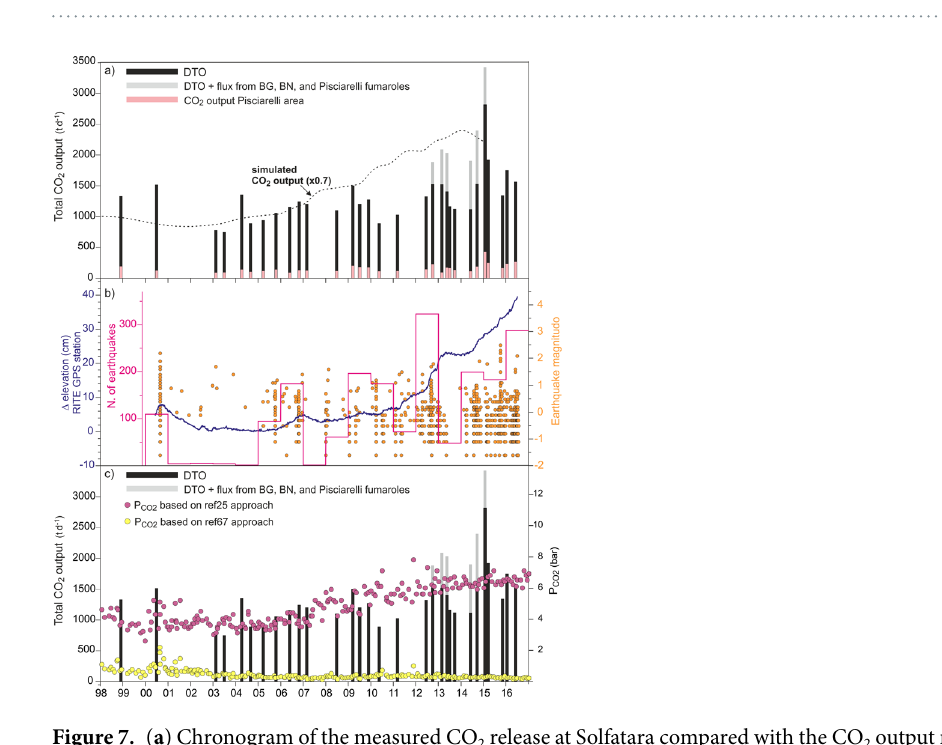
Figure 6. Time variation of the Solfatara background flux (SBF) ( a ) and diffuse degassing structure (DDS) extension ( b ) compared with the fraction of condensation 25 ( f ) computed for the Solfatara main fumaroles (BG, BN). The variable f refers to the fraction of the water removed (sign + ) or added (sign − ) during the transfer of the gas from the gas equilibration zone to the fumarole (see Methods). The mean of the biogenic CO 2 flux estimated for Solfatara 58 is reported as reference in ( a ).